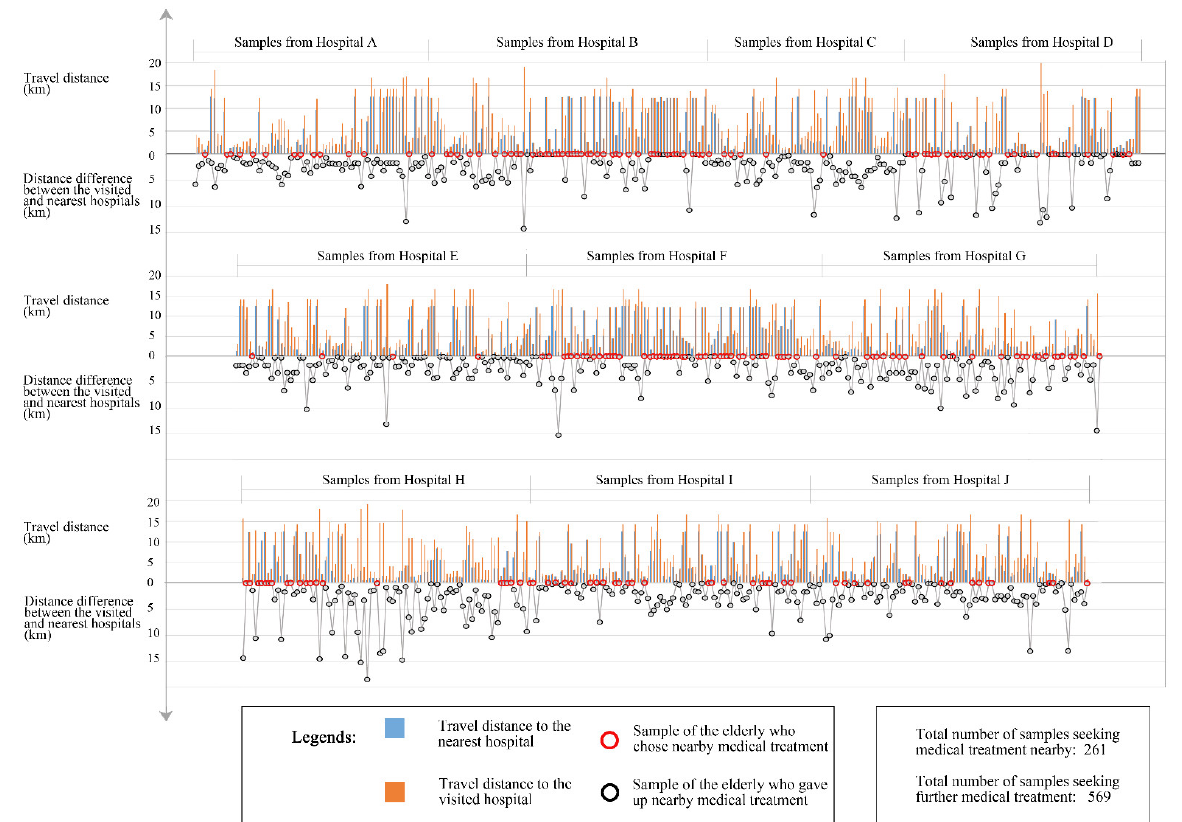
Figure A1. Comparison of the distances from each residence to the nearest and the visited hospital.